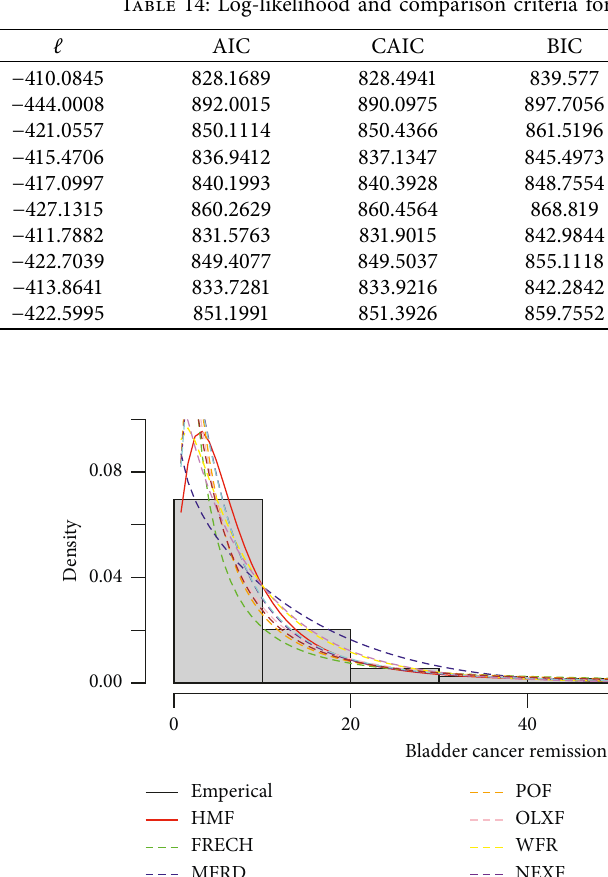
Figure 7: Fitted PDFs for bladder cancer survival time